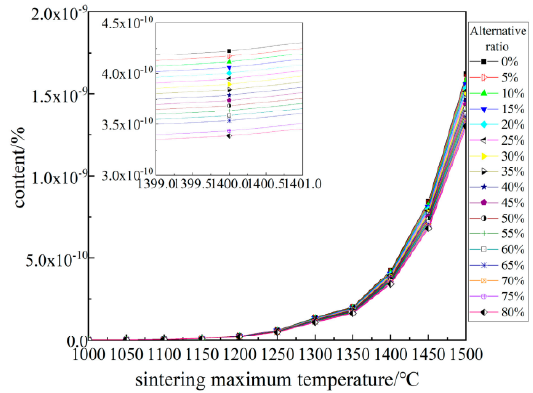
Figure 4. Change of S content in the case of straw charcoal